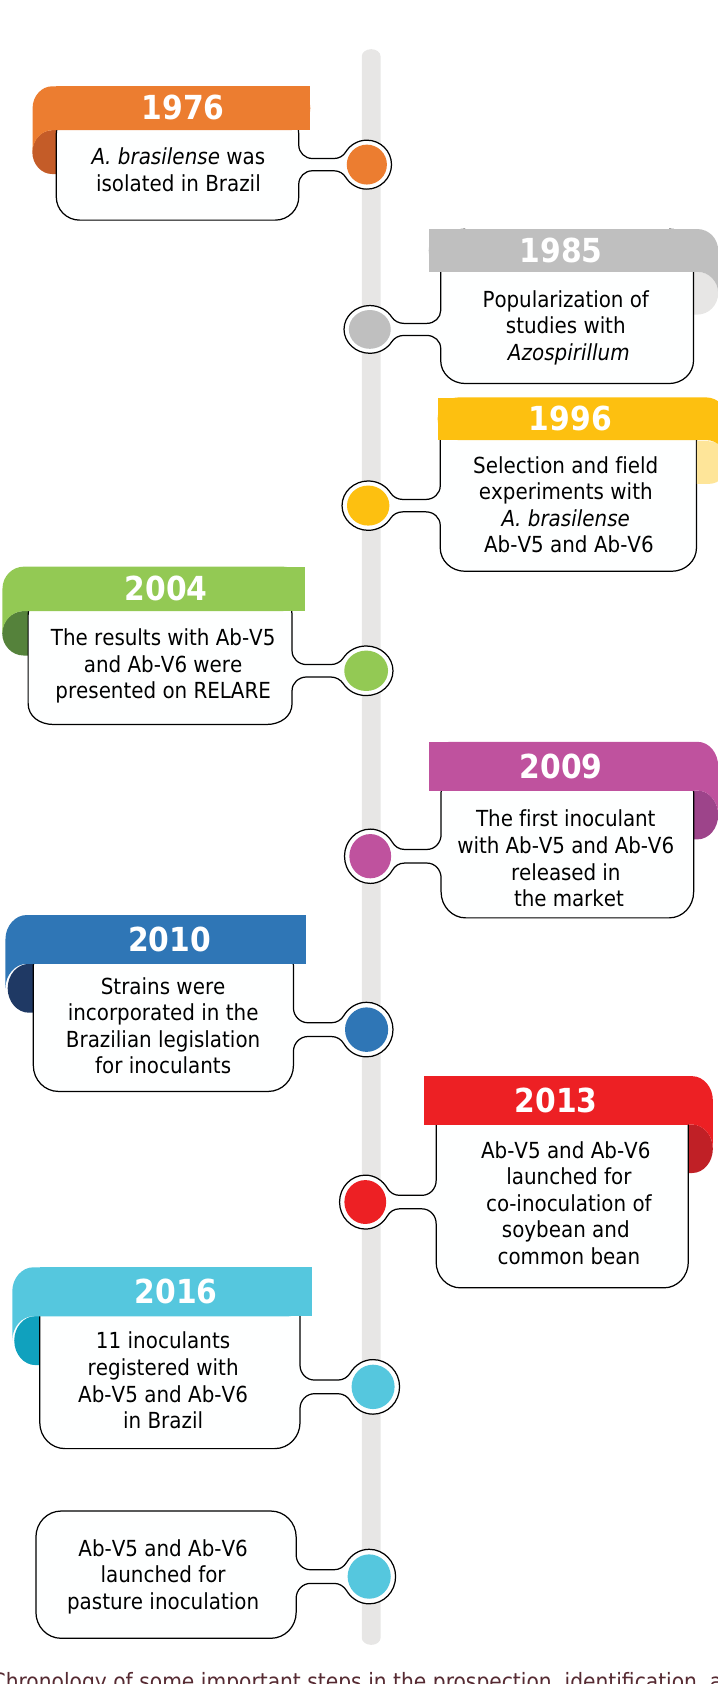
Figure 4. Chronology of some important steps in the prospection, identification, and release of Azospirillum brasilense strains Ab-V5 and Ab-V6 in Brazilian